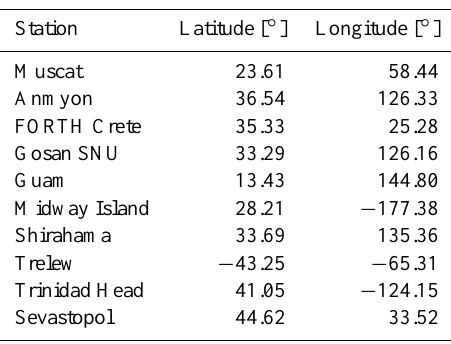
Table 1. A selection of the near-ocean AERONET stations that have been used in the